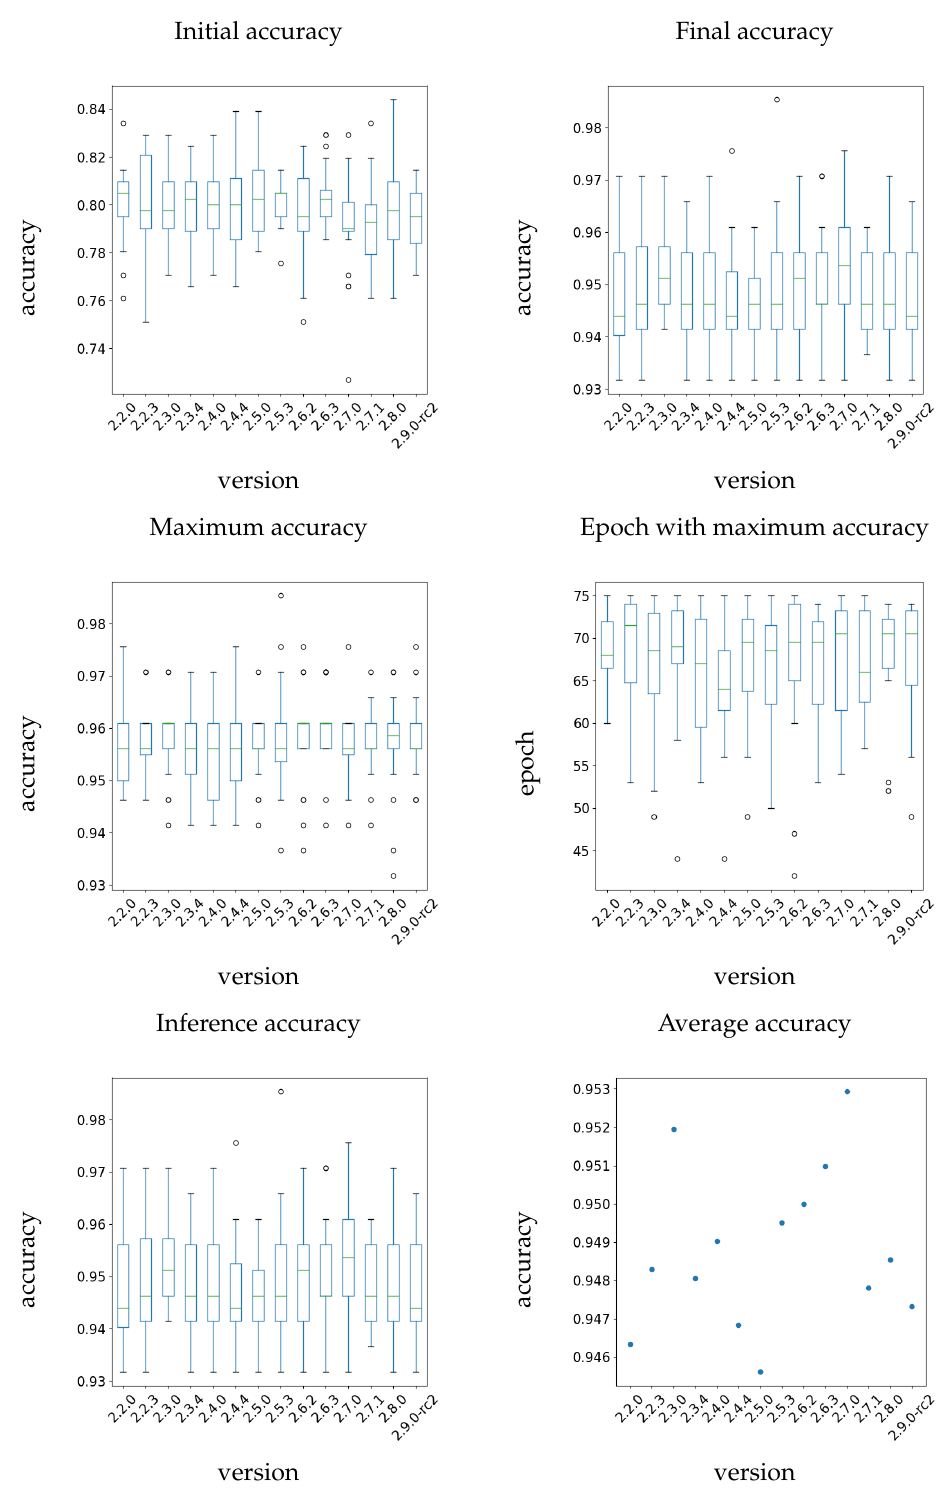
Figure 4. The results for the heart-disease dataset using